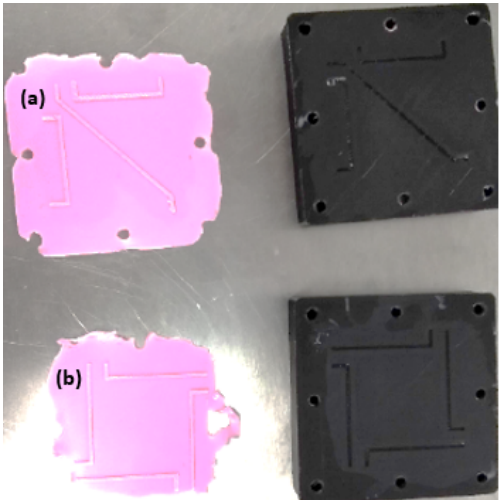
Figure 4. Examples of two generated MR elastomers with 90% silicone rubber and 10% catalyst. Depicted patterns are ( a ) 3-line array with 90 ◦ and 45 ◦ between them, and ( b ) 4-line array with 90 ◦ between them.